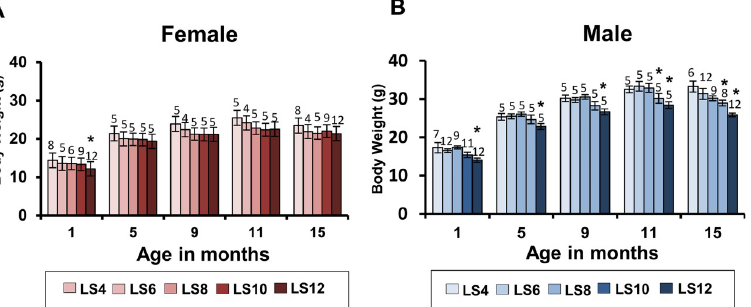
Fig 1. Effect of litter expansion on body weight. The body weight of female and male mice from different litter sizes (LS4, LS6, LS8, LS10, LS12) were measured at 1, 5, 9, 11, and 15 months of age. Data represented are the mean ± SEM from 4–12 mice per group. All groups were compared to control LS6 and were statistically analyzed by one-way ANOVA with Tukey’s and FDR with Benjamini & Hochberg multiple correction test ( � p < 0.05). Statistics was done separately for each